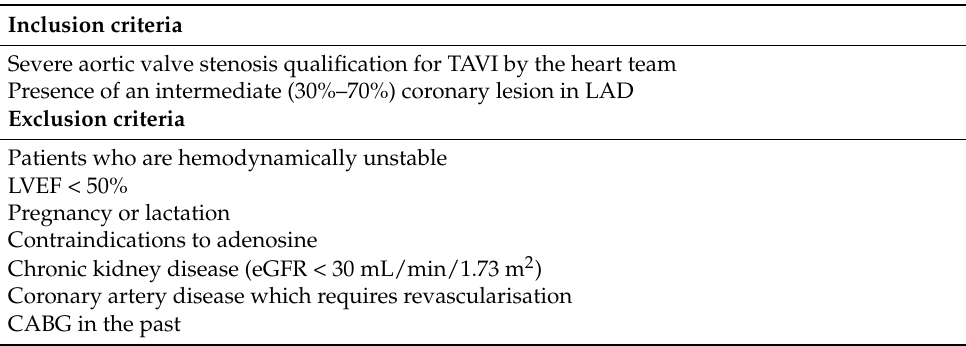
Table 1. The summary of inclusion and exclusion